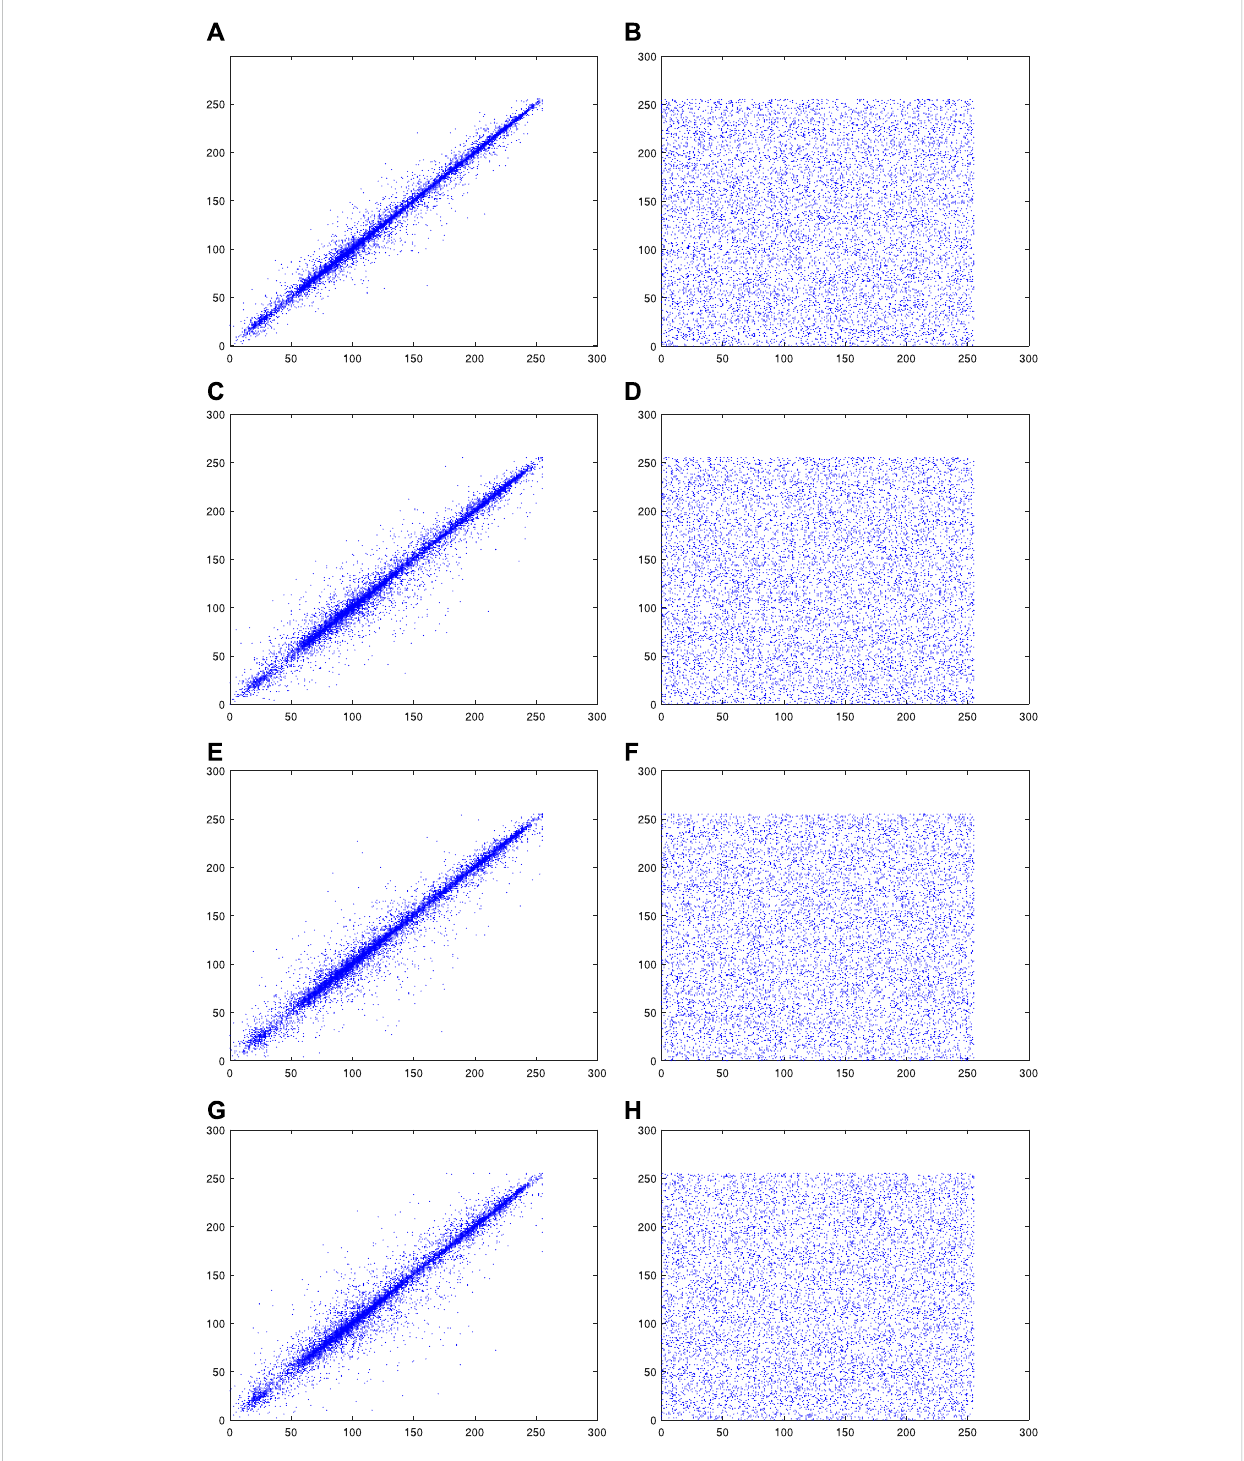
FIGURE 7 Correlation testresult of Lena: (A) Horizontal diagonal of theplaintext image, (B) horizontaldiagonalofthe ciphertext image, (C) vertical diagonal of theplaintextimage, (D) vertical diagonal oftheciphertextimage, (E) positive diagonal oftheplaintextimage, (F) positive diagonal oftheciphertextimage, (G) opposition diagonal of the plaintext image, and (H) opposition diagonal of the ciphertext